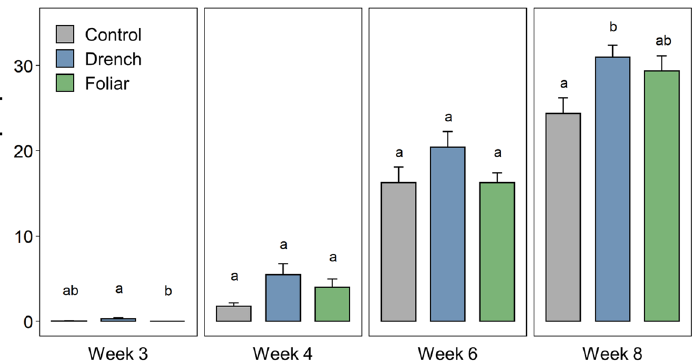
Figure 4. The number of root segments per M. truncatula plant maximally colonized by R. irregularis following treatment with ANE foliarly, drench or neither (control) through weeks 3 to 8 of greenhouse growth. Maximum colonization was defined as an intensity score of 5 and an arbuscule score of 3, with 50 root segments analyzed for 10 randomly selected plants per treatment per week. Letters indicate the significance groups determined via a Kruskal–Wallis test followed by a Dunn’s post-hoc test, α = 0.05.